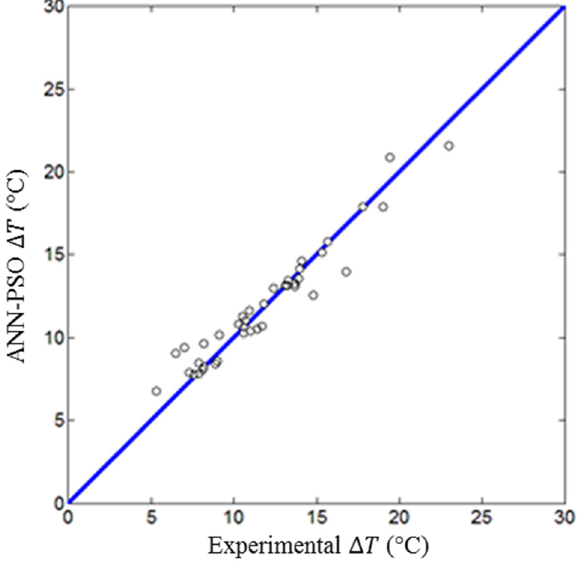
Figure 11. Estimated temperature difference by ANN-PSO based on experimental data (test stage).